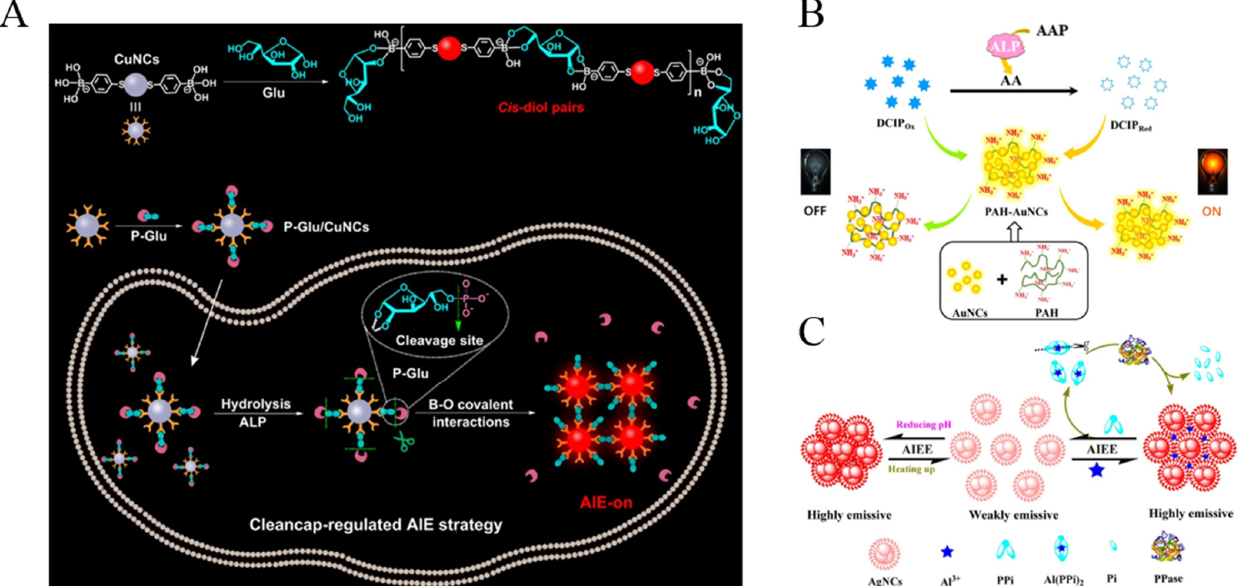
Figure 8. ( A ) Schematic illustration of (top) the proposed mechanism for specific recognition between MBA-stabilized CuNCs and glucose and (bottom) the cleancap-regulated AIE strategy for the imaging of ALP activity. Reprinted with permission from ref. [72]. Copyright 2020, American Chemical Society. ( B ) Schematic illustration of the detection strategy for ALP activity based on FRET. Reprinted with permission from ref. [73]. Copyright 2019, Elsevier. ( C ) Schematic illustration of AIEE-based AgNC nanoswitches in response to multiple stimuli and a detection strategy for PPase activity based on ion-triggered switch. Reprinted with permission from ref. [75]. Copyright 2017, American Chemical Society.